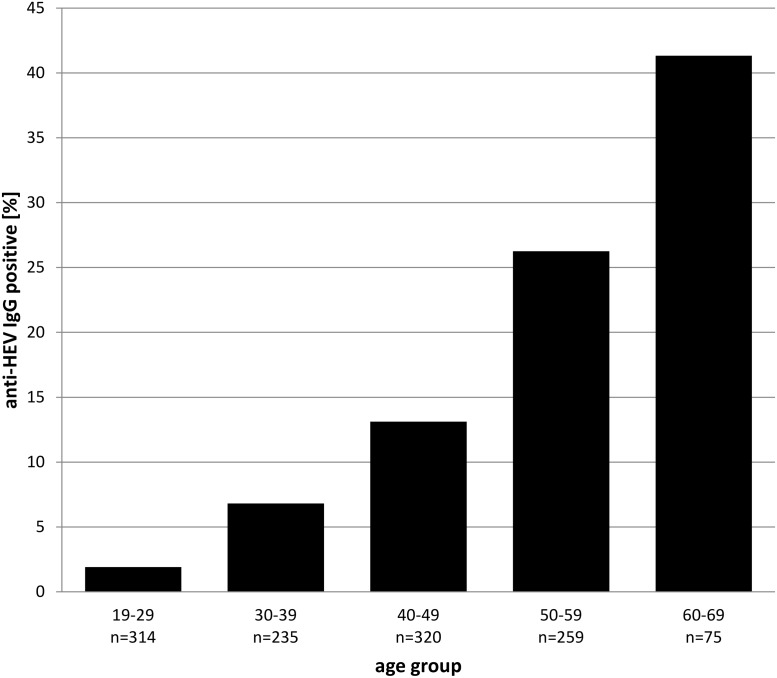
Prevalence of anti-HEV IgG.Estimated prevalence of anti-HEV IgG in 1,203 of Upper Austrian blood donors by age group.